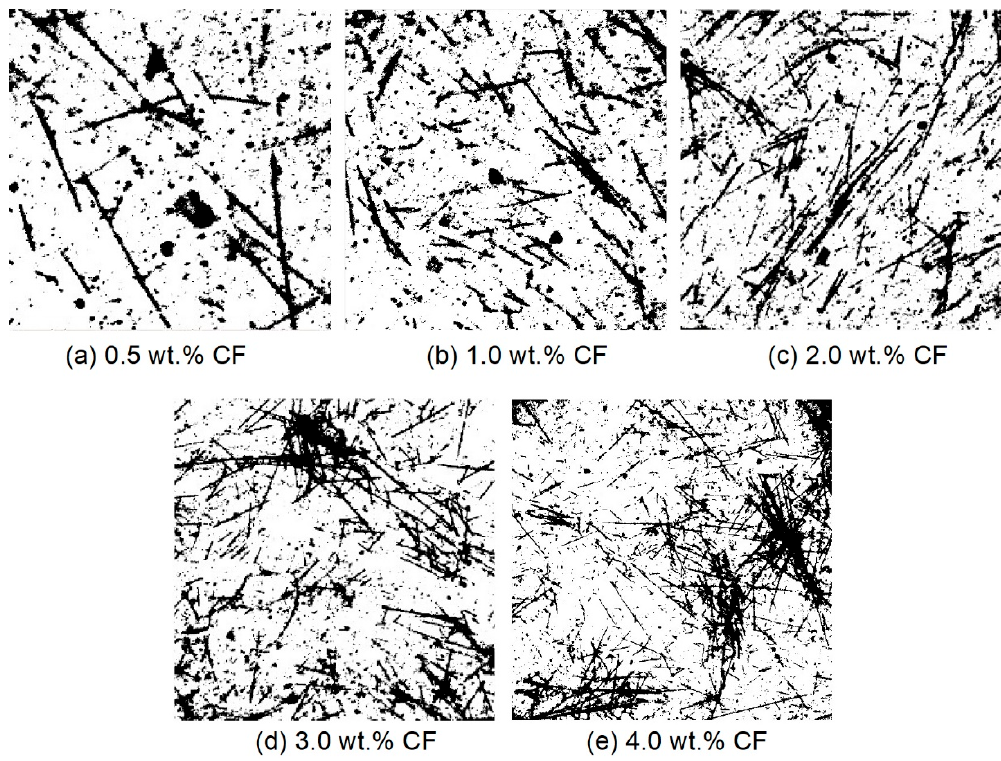
Figure 8. Original images of carbon fibers in the contact-hardening composites with different fiber contents: ( a ) 0.5 wt.%;